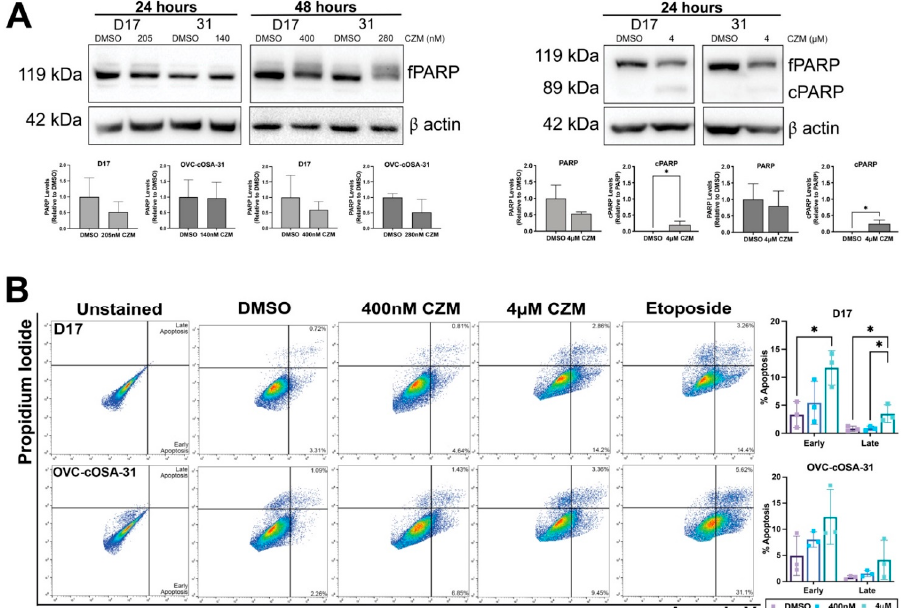
Figure 4. Capzimin induces apoptosis in a dose-dependent manner in canine OS cells. ( A ) CZM exposure at the calculated IC 50 dose leads to a reduction in full length PARP (fPARP), but an associated increase in the cleaved version of PARP (cPARP) was not observed at either 24 or 48 h (left). However, when cells were treated with the 4 μ M dose of CZM, the associated increase in cPARP was more evident (right). Immunoblots are from one representative experiment. fPARP levels were normalized to β actin (loading control) and compared to the DMSO control group to determine relative differences. cPARP levels were first normalized to β actin and are depicted as changes rela- tive to normalized fPARP levels. Densitometry graph shows mean ± SD from n = 3 independent experiments; * indicates p < 0.05 as determined by an unpaired, two-tailed t -test. ( B ) Annexin V/Pro- pidium Iodide flow cytometry analysis of OS cells treated with a low and high dose of CZM. A high dose of CZM significantly increases the percentage of early and late apoptotic D17 cells. Increases were seen in both cell lines when treated with the 400 nM of CZM, but these differences were not statistically significant. Graphs depict mean ± SD from n = 3 independent experiments; * indicates p < 0.05 as determined by a one-way ANOVA and post-hoc Tukey’s multiple comparison’s test.